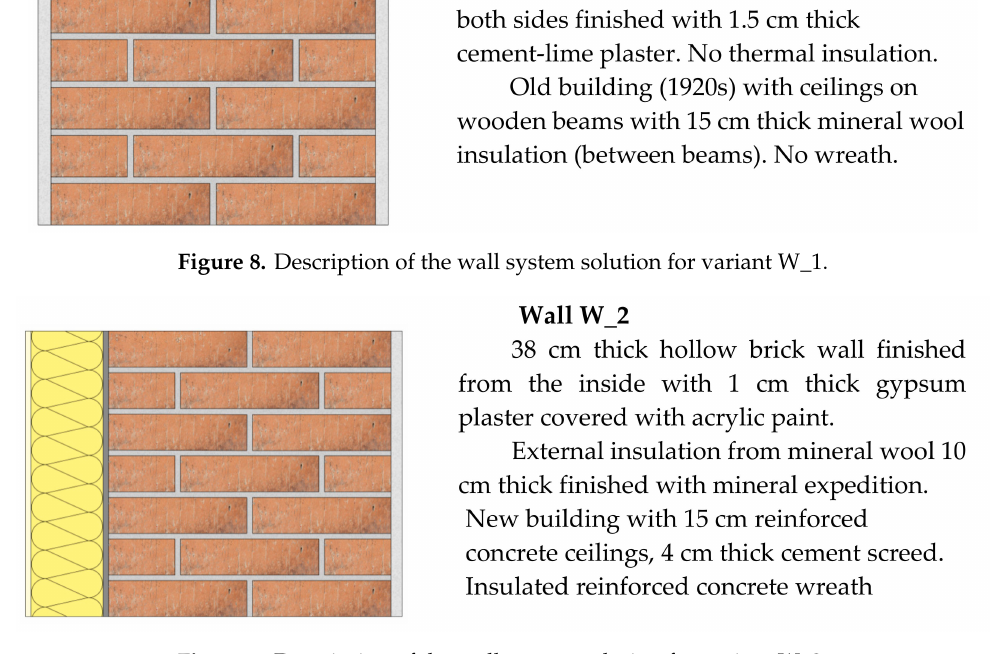
Figure 9. Description of the wall system solution for variant